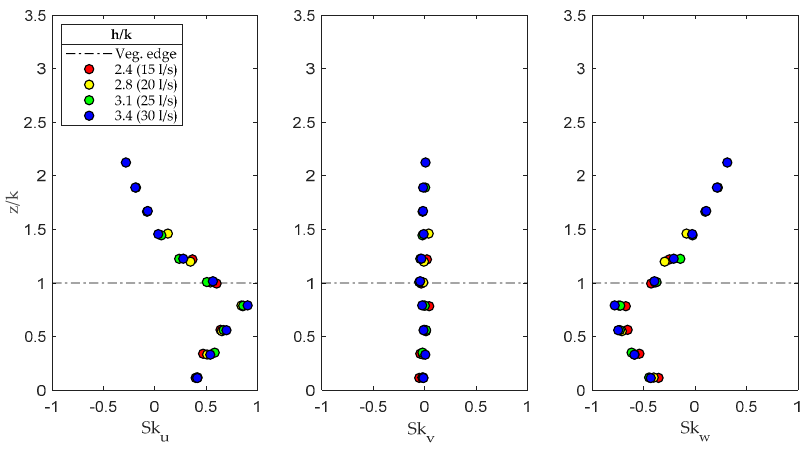
Figure 5. Skewness of the fluctuation velocity components in the three directions x, y, and z.